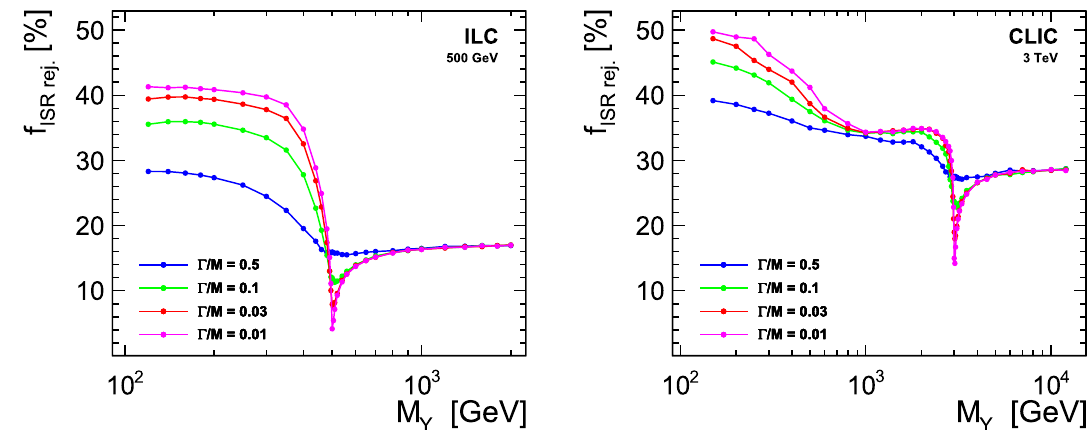
Fig. 4 Fraction of Whizard events, which are removed by the ISR rejection procedure, as described in [4]. See text for details